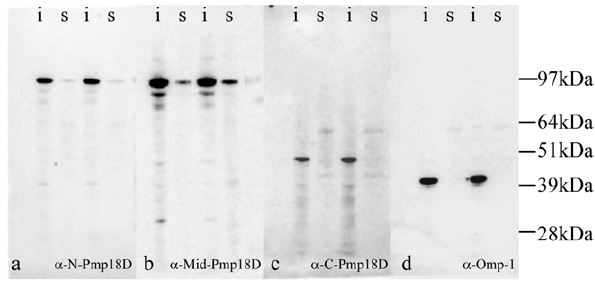
Figure 2. Western blot demonstrating the presence of the majority of Pmp18D in the insoluble material after sonication in PBS 48 h post-infection: a) anti-N-Pmp18D, b) anti-Mid- Pmp18D, c) anti-C-Pmp18D and d) anti-Omp-1 mAb